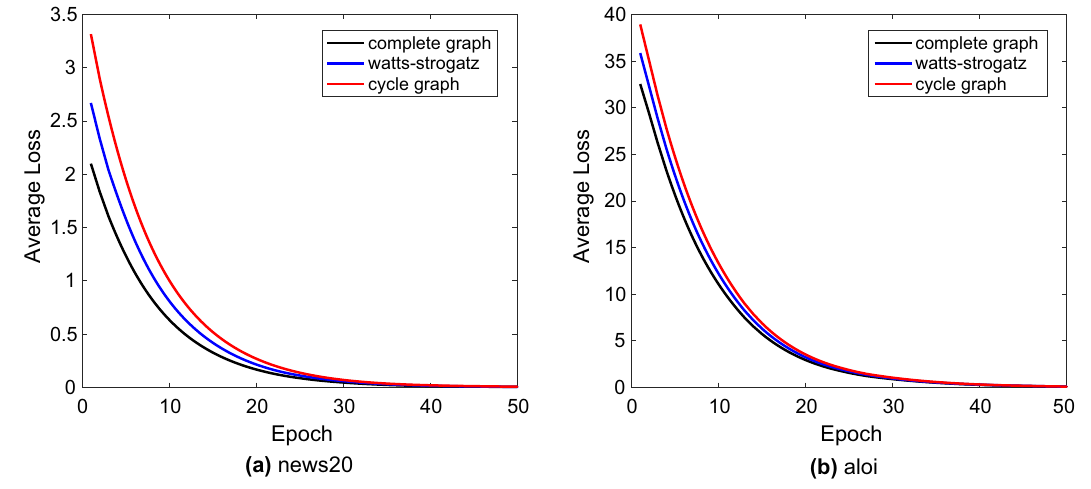
Fig. 3 Comparison of the proposed algorithm with different topologies on news20 and aloi